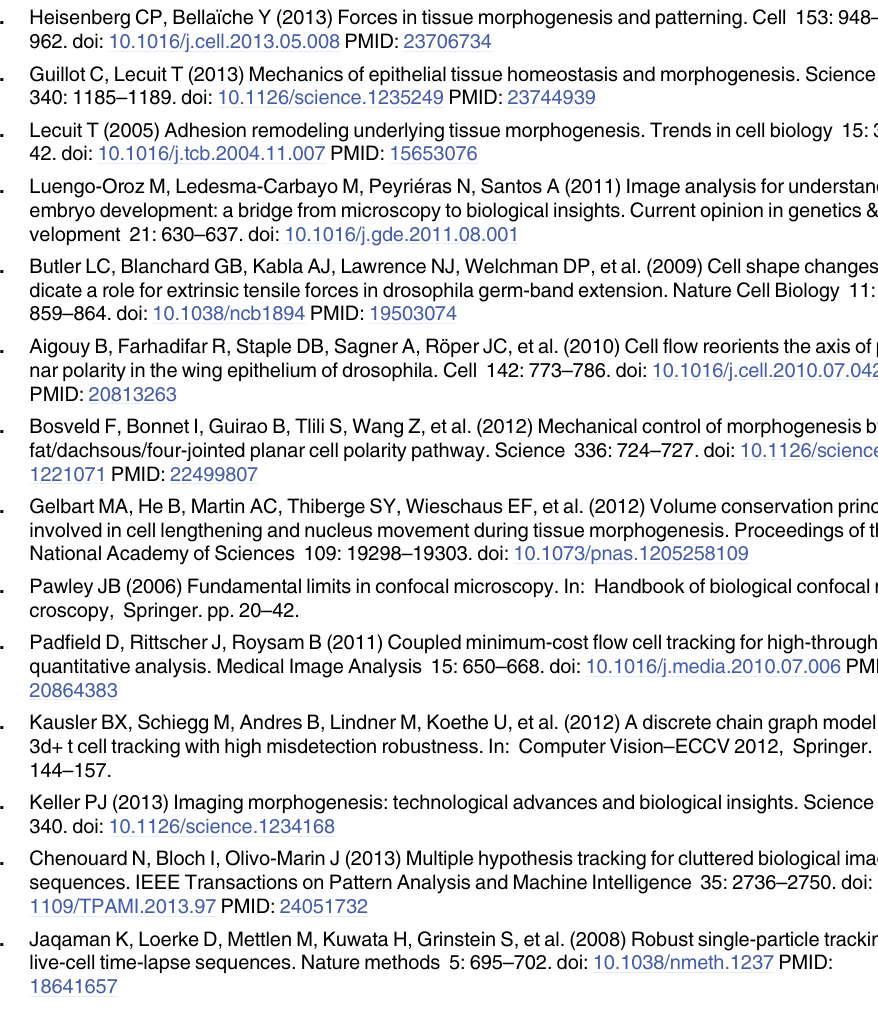
S1 Table. Description of the datasets employed to evaluate the segmentation and tracking